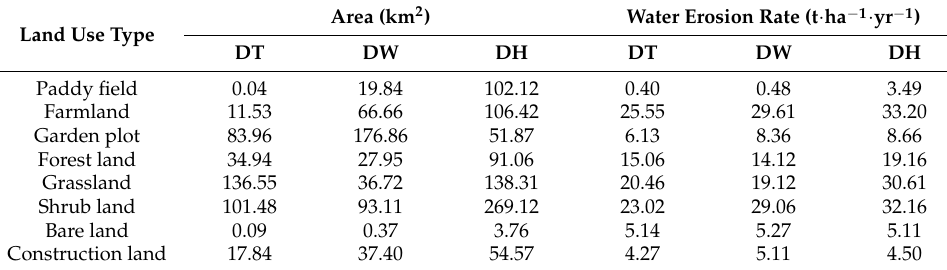
Table 6. Water erosion rates over different land use